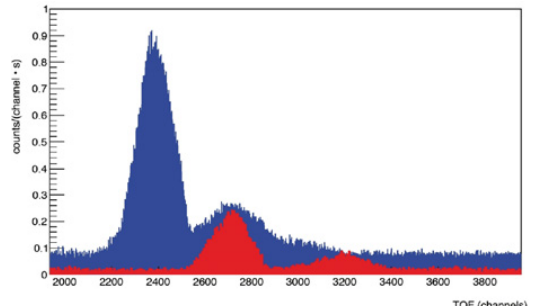
Figure 18. Blue: Secondary electron production by 500eV protons, accelerated to 18keV at the foil position in the degrader. Red: Proton (500 eV) distribution at 0V voltage in the degrader. The proton source H 2 pressure was 3 · 10 − 3